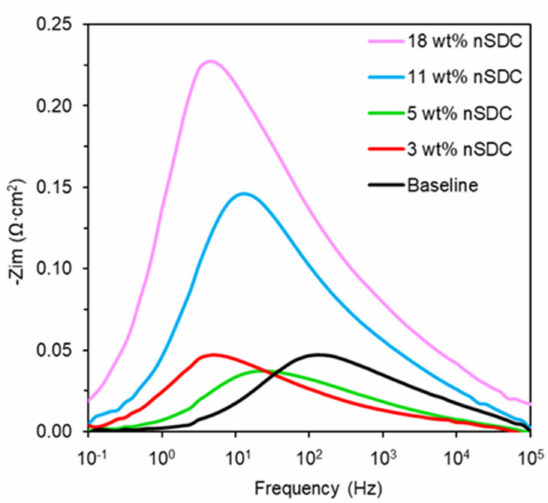
Figure 4. Bode plots for LSCF-SDC-nSDC symmetrical cells as a function of nSDC loading tested at 700 ◦